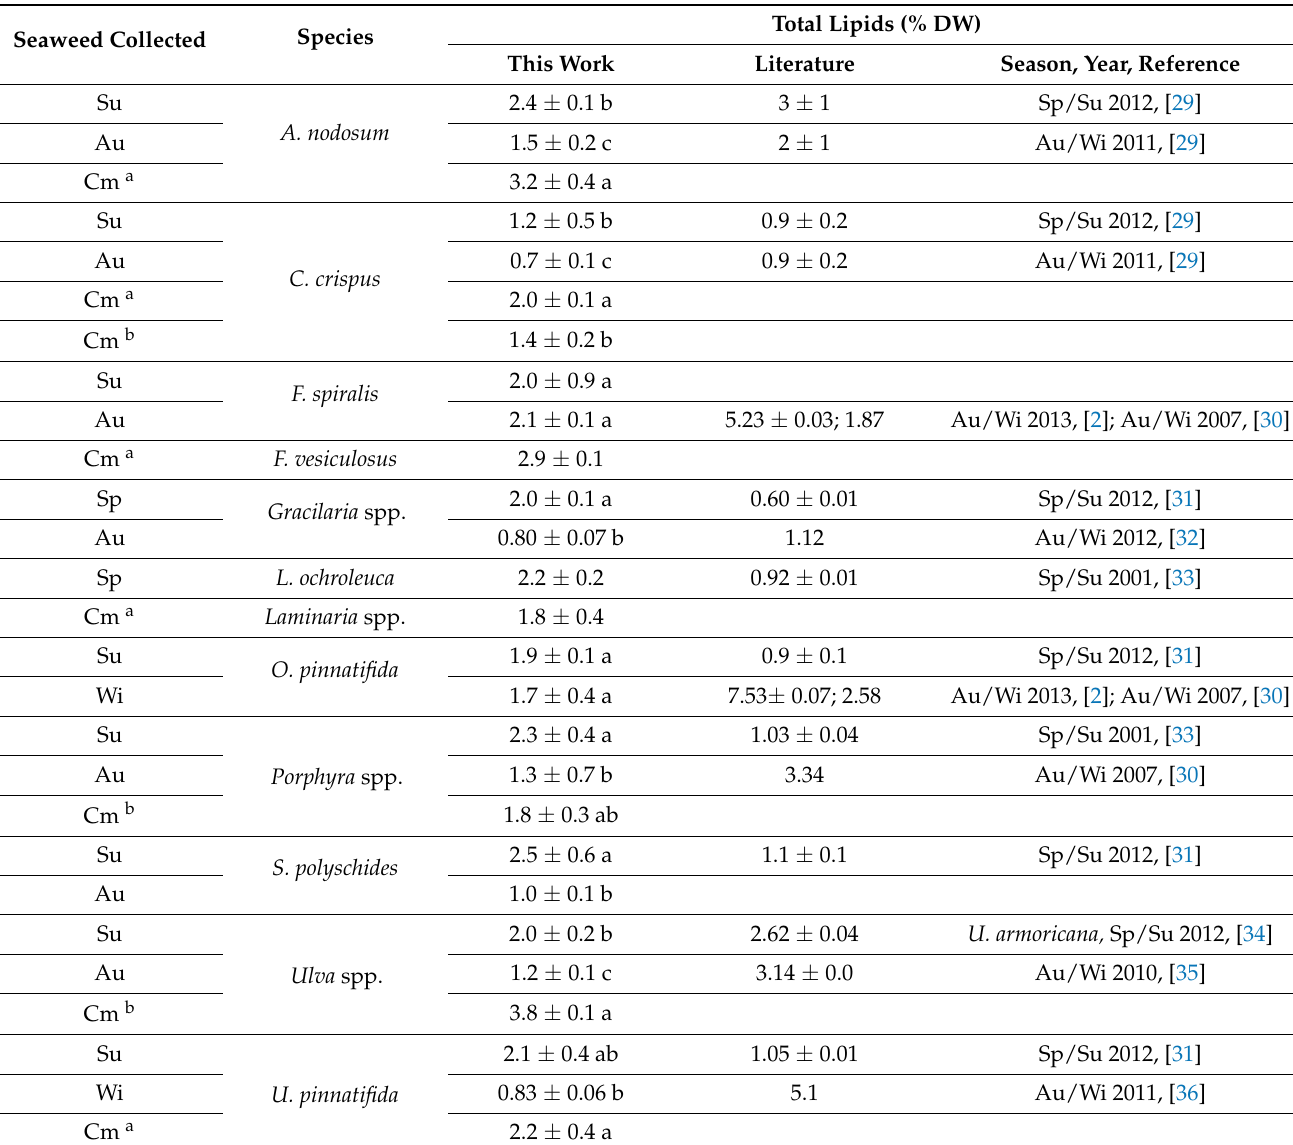
Table 1. Quantity of total lipids (mean ± SD % DW) in different seaweeds species and comparison with values reported in the